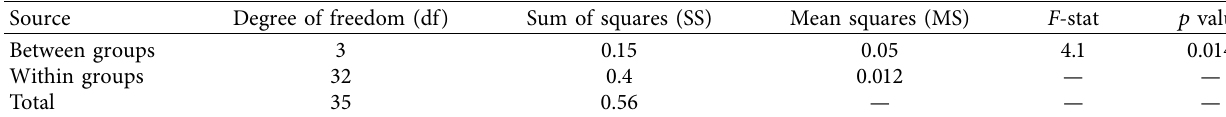
Table 5: ANOVA table for bulk density of different forest types.